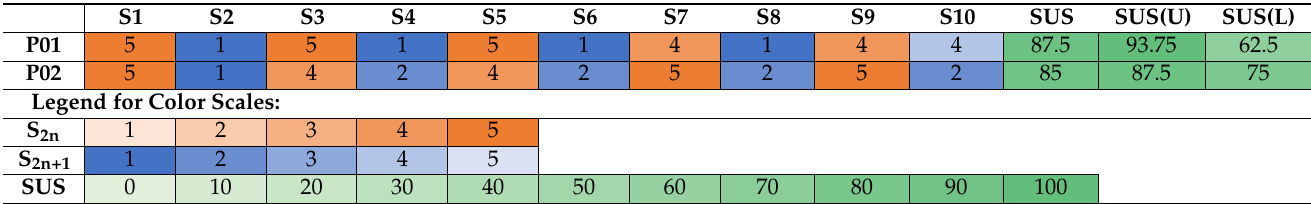
Table A5. Results of the application of the SUS questionnaire to two physiatrists at T1.